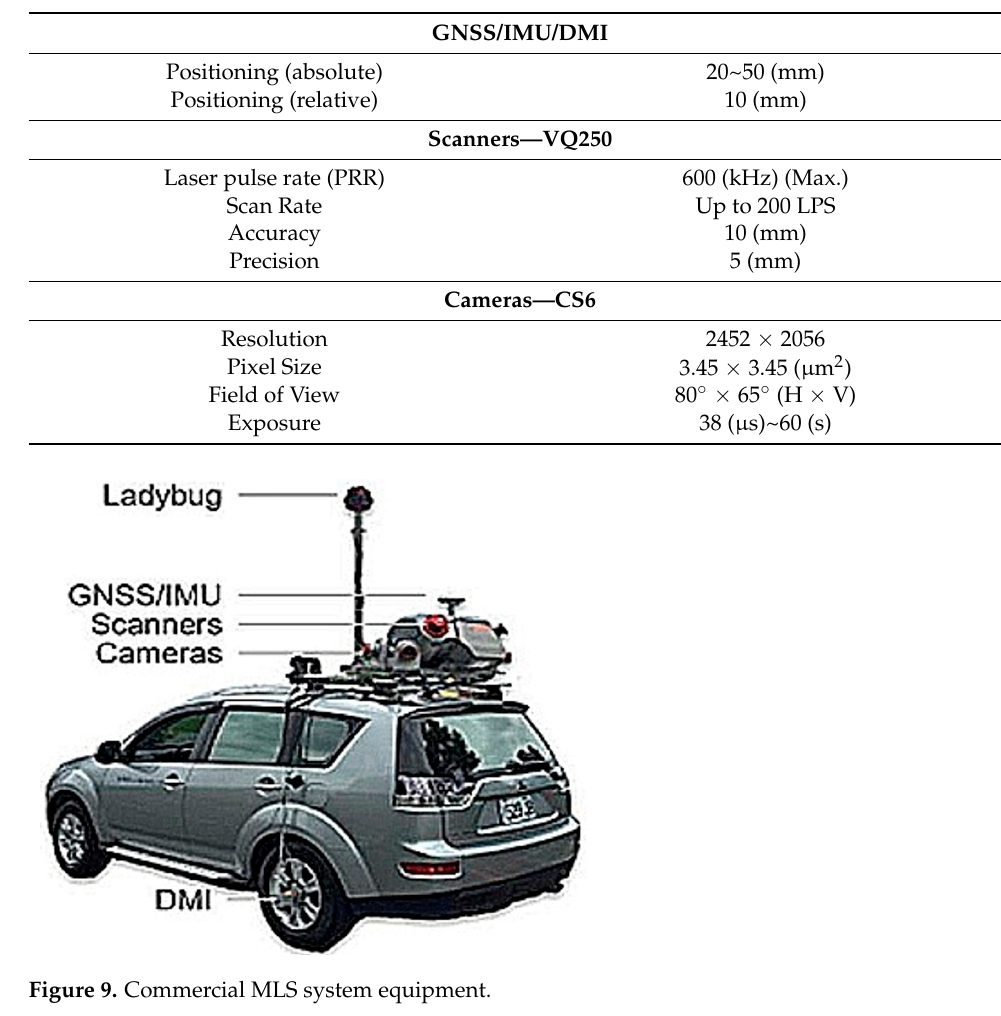
Table 2. Specifications of sensors.